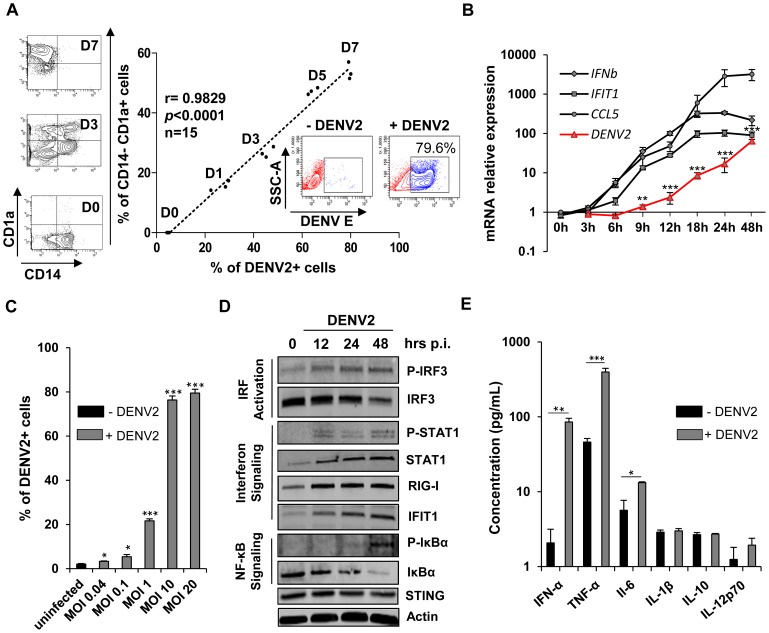
Mo-DC are highly susceptible to DENV infection and generate a broad antiviral and inflammatory response.(A) The correlation between the percentage of infected cells determined by intracellular staining of DENV E protein expression and the percentage of CD14− CD1a+ Mo-DC was calculated during the course of Mo-DC differentiation (n = 15; Spearman test). The FACS panels on the left hand side represent the progression of Mo-DC differentiation at days 0, 3 and 7. (B) DENV RNA levels as well as IFN-β, IFIT1, and CCL5 gene expression levels were determined by qPCR at various times of DENV2 infection (MOI 10). P values were determined based on the comparison with cells at time 3 h after infection. Data are from one experiment performed on three individual donors. (C) Mo-DC were infected with increasing amounts of virus (MOI 0.04-MOI 20) for 24 h. Percentage of DENV2-infected cells was determined by intracellular staining (ICS) of DENV E protein expression using flow cytometry. Data are the means ± SEM from one experiment performed on three different donors. (D) Mo-DC were challenged with DENV2 (MOI 20) and antiviral and inflammatory responses were examined by immunoblotting. Data are from one representative experiment. (E) Cytokine release was evaluated by cytokine bead array (CBA) 24 h after DENV2 challenge (MOI 10) in the supernatants of infected cells. P values were determined based on the comparison with uninfected cells. Data are the means ± SEM from one experiment performed on three different donors.